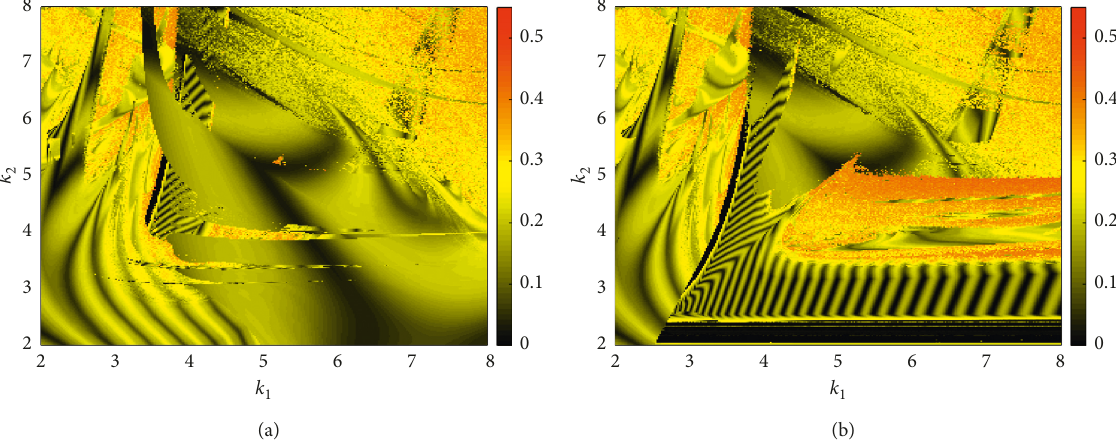
1 - k 2 parameter plane under two sets